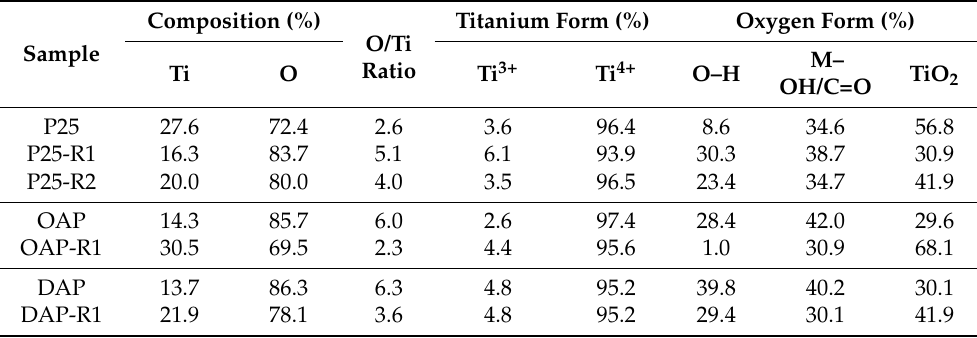
Figure 2. XRD data of pristine and reduced titania: ( a ) P25; ( b ) ST01; ( c ) TIO-2; ( d ) OAP; ( e ) DAP; and ( f ) magnification of main (101) anatase peak for P25- and OAP-based samples. Table 1. XPS data for titanium (2p 3/2 ) and oxygen